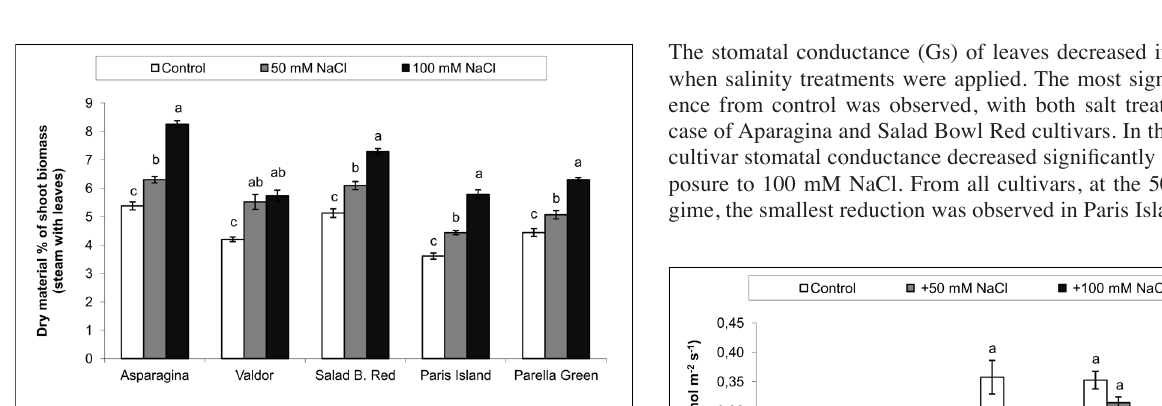
Fig. 1: Effect of 50 mM and 100 mM NaCl on the shoot and root fresh weight (FW) of five lettuce cultivars. Data are means of five plants ± SE. Different letters indicate significant differences among treatments of the same cultivar, at P < 0.05, according to the Tukey test.